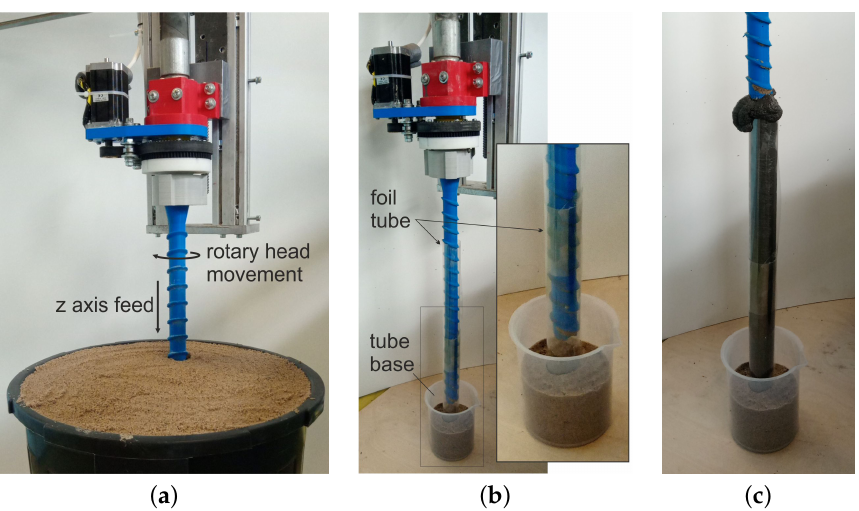
Figure 6. Tests for drill performance determination, ( a ) test of drill immersion, ( b ) test of pile extrusion in foil tube—starting position, ( c ) evaluation of tube filling with concrete (concrete extruded to